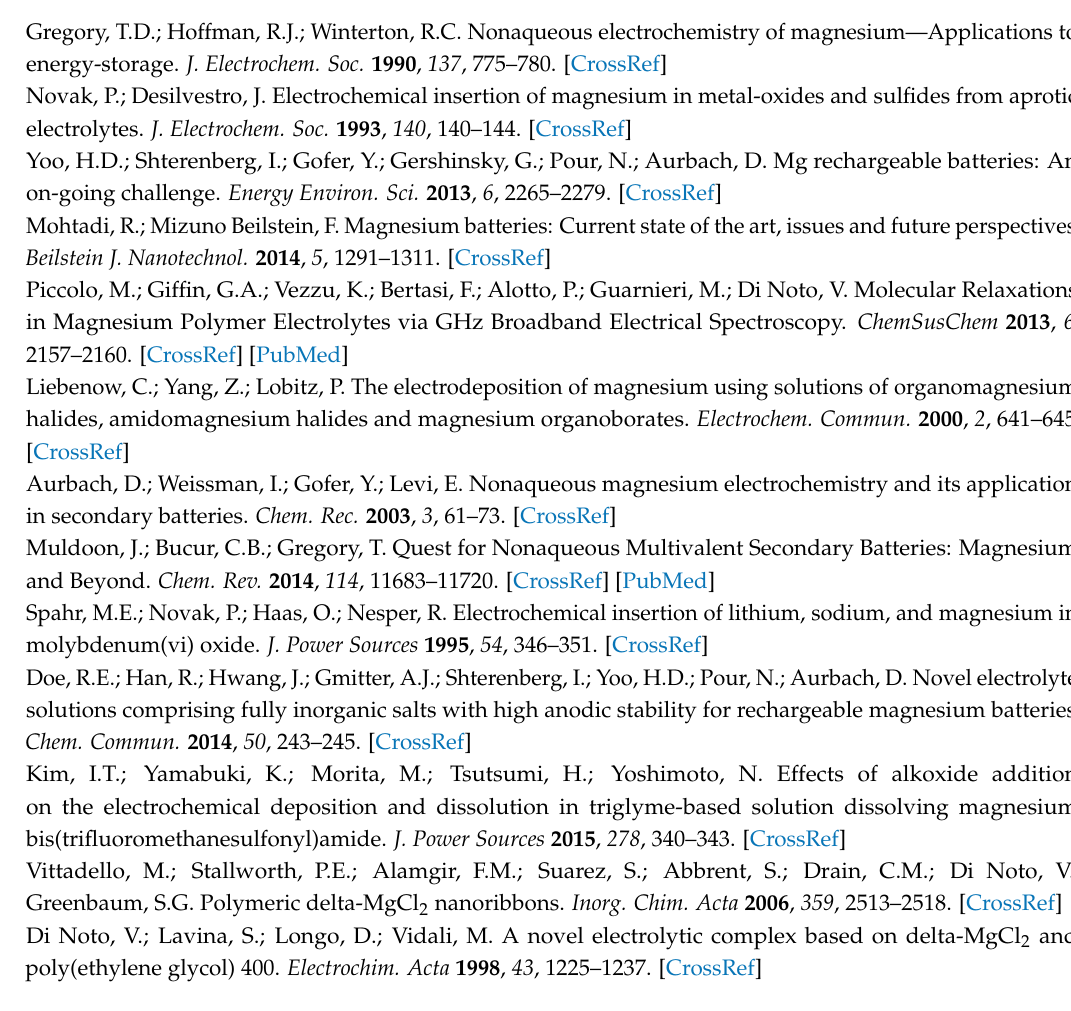
Figure S1. Galvanostatic discharge/charge curves of LTO sample in a three-electrode Mg cell using 0.5 M Mg(TFSI) 2 in DME. Figure S2. Galvanostatic discharge/charge curves of LTO sample in a three-electrode Mg cell using 0.5 M Mg(TFSI) 2 + 0.13 M MgCl 2 · 6H 2 O in DME electrolyte in different current collector: (a–c) Ti foil and (d) C